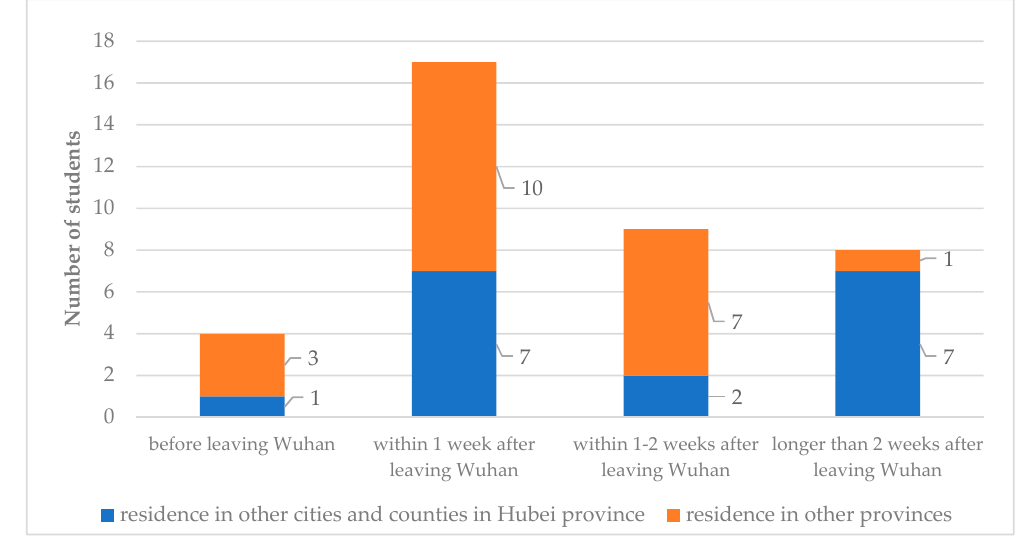
Figure 2. Distribution of the gap between time of departure from Wuhan to time of disease onset in students ( n = 38).